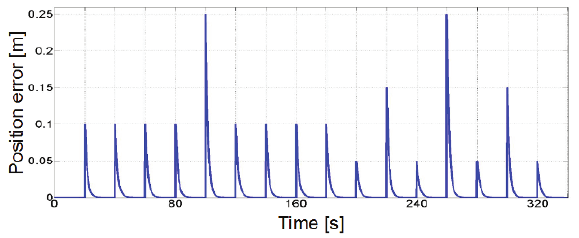
Figure 7. Overall task space position error (sum of the absolute values of the X , Y and Z components) of the hand during the test movement us- ing IMLE. Every 20 seconds the target position is changed and the position error raises accordingly; the particular trajectory of the error reduction during the movements is a further proof of the good esti- mation of the Jacobian.